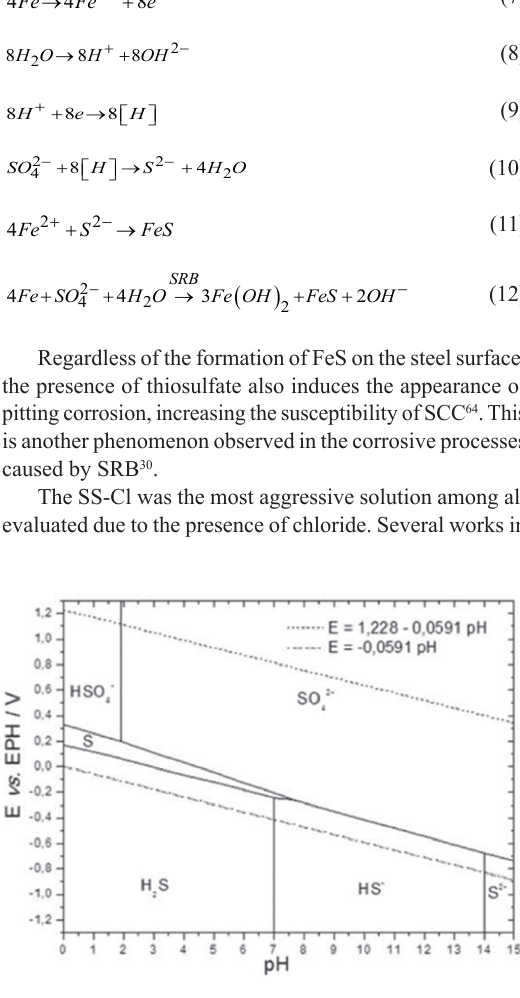
S thermodynamic 2